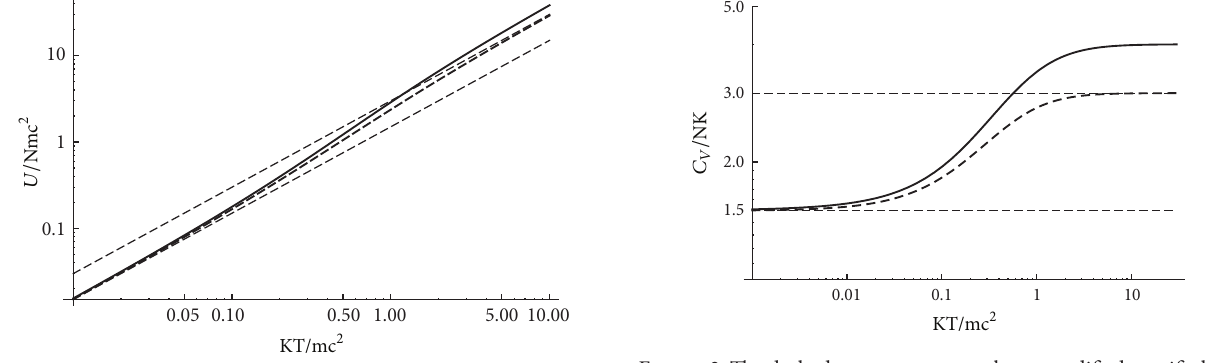
Figure 1: The dashed curves represent the unmodified internal energy and its non- and ultrarelativistic limits. The solid curve represents the modified internal energy.